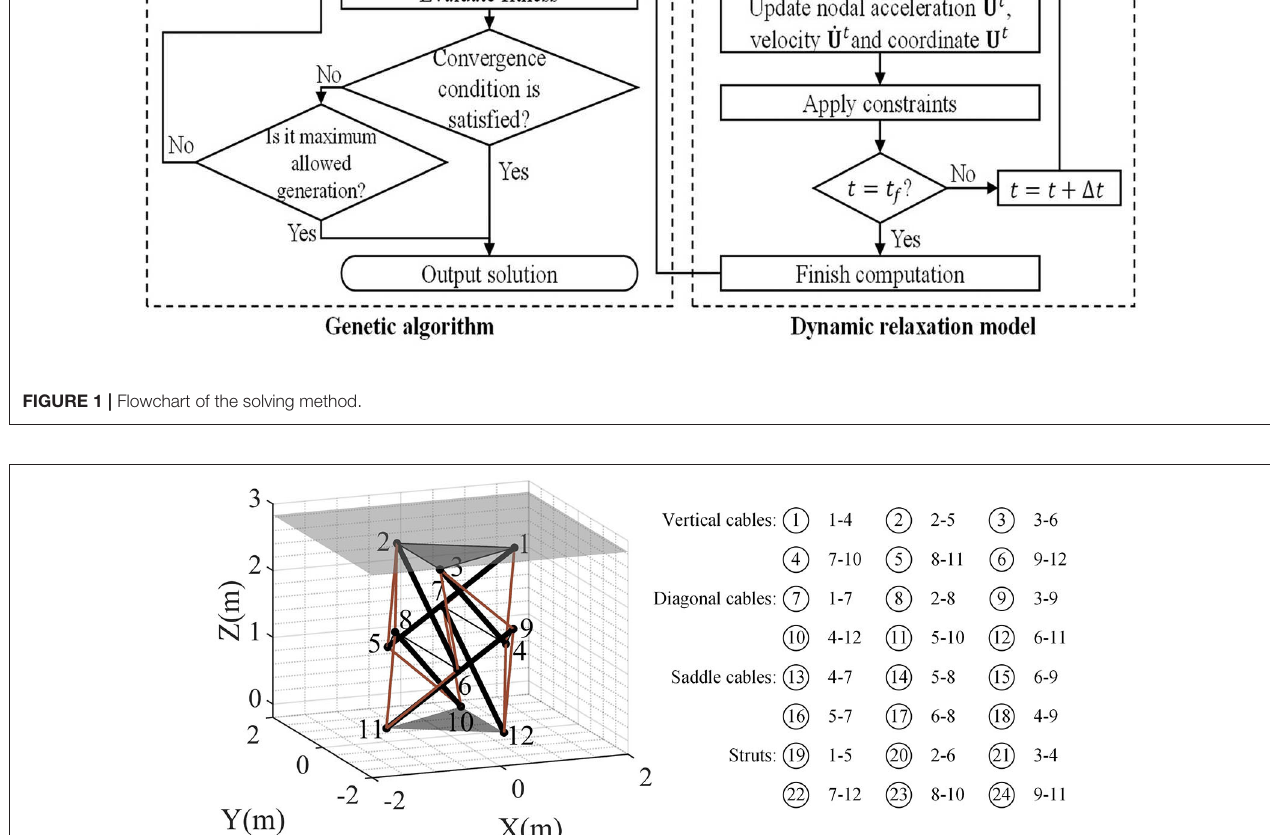
FIGURE 2 | Shape-controlled double-layered tri-prism tensegrity structure.